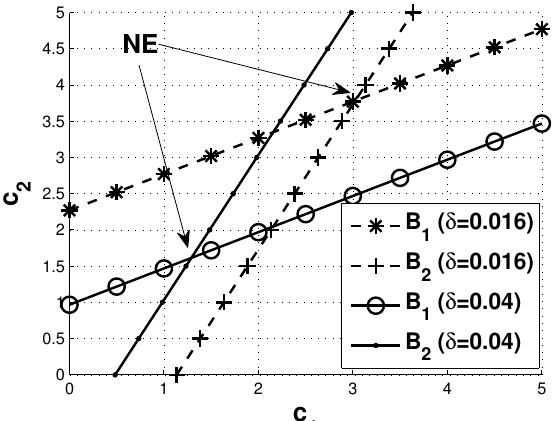
Figure 4. Existence and uniqueness of the Nash equilibrium (NE) in the non-cooperative competitive pricing game among